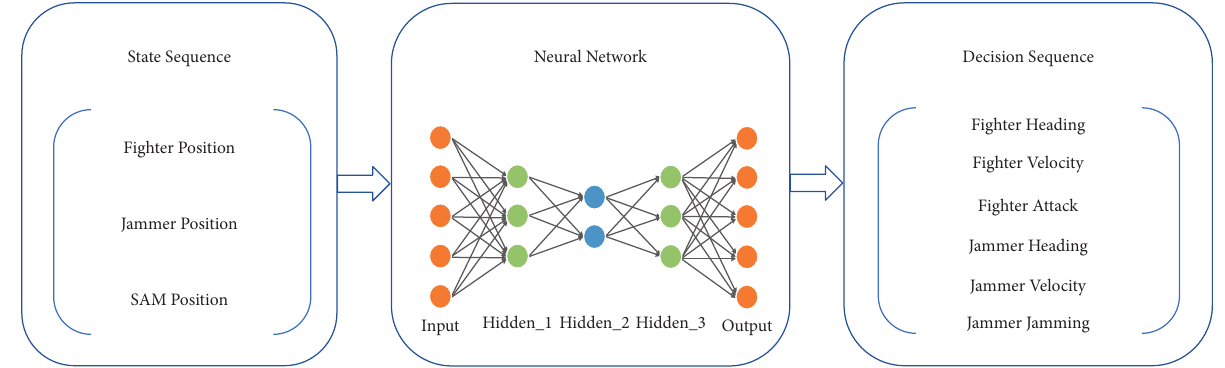
Figure 2: Intelligent mission planning SEAD model.